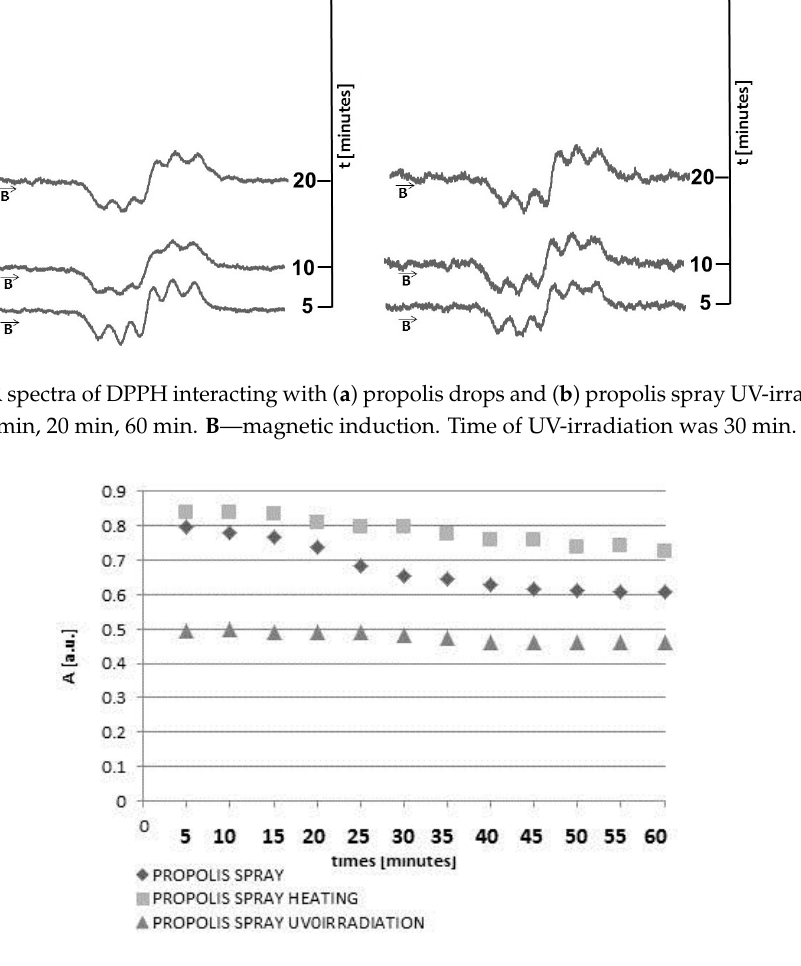
Figure 6. The effect of heating at the temperature of 50 °C and UV-irradiation on changes of amplitudes (A) of EPR lines of DPPH in contact with propolis spray with increasing interaction time (t). Times of both heating and UV-irradiation were 30 min.